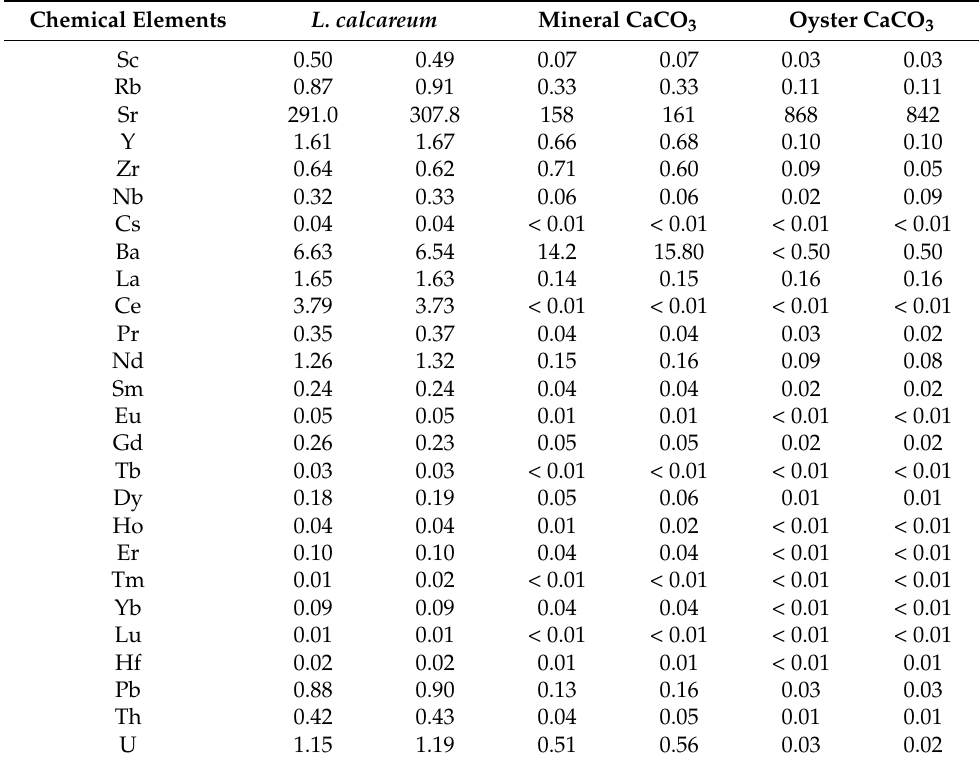
Table 4. Content of trace elements (ppm) of samples (in duplicate) of L. calcareum , inorganic mineral and oyster shell CaCO 3